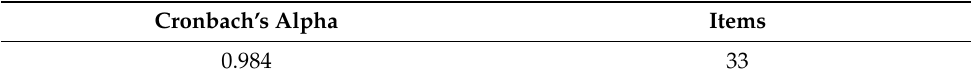
Table 5. The overall reliability